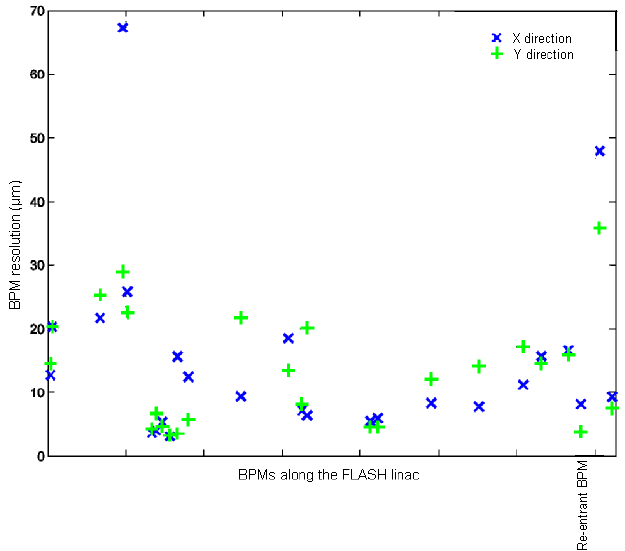
FIG. 18. (Color) Resolution calculated for the reentrant BPM installed in the warm part of the FLASH linac.